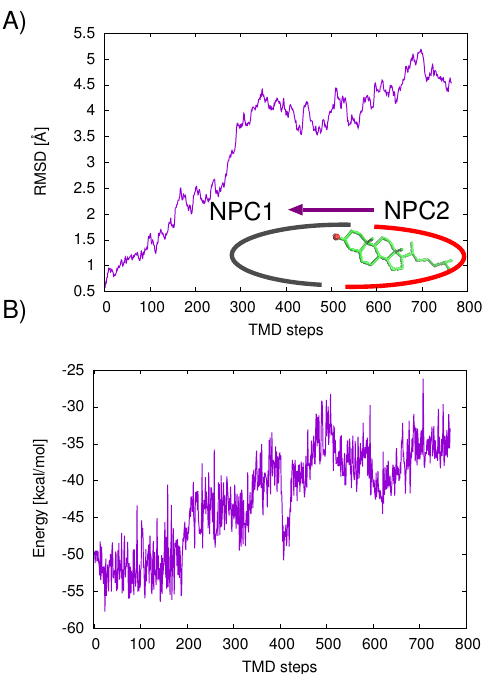
Figure 7. For the Texas model, TMD results of cholesterol transfer in the direction NPC2 → NPC1 (purple line) are analyzed: ( A ) protein backbone RMS differences (Å); and ( B ) cholesterol–protein potential energies associated with each TMD path are plotted for the TMD path.